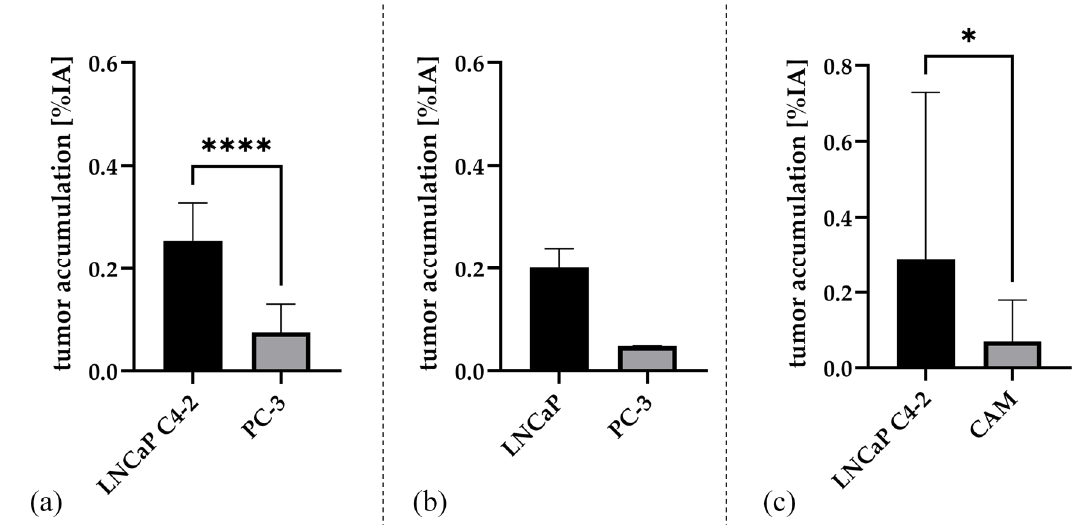
Figure 3. Mean and standard deviation of the three groups after paired evaluation of the tumor accumulation [%IA] test for ( a ) [LNCaP C4-2 + PC-3] ( n = 34), ( b ) [LNCaP + PC-3] ( n = 3), and ( c ) [LNCaP C4-2 + CAM] ( n = 5). Significance of the pairwise comparison is indicated ( p -values: **** p < 0.0001; * p < 0.05).